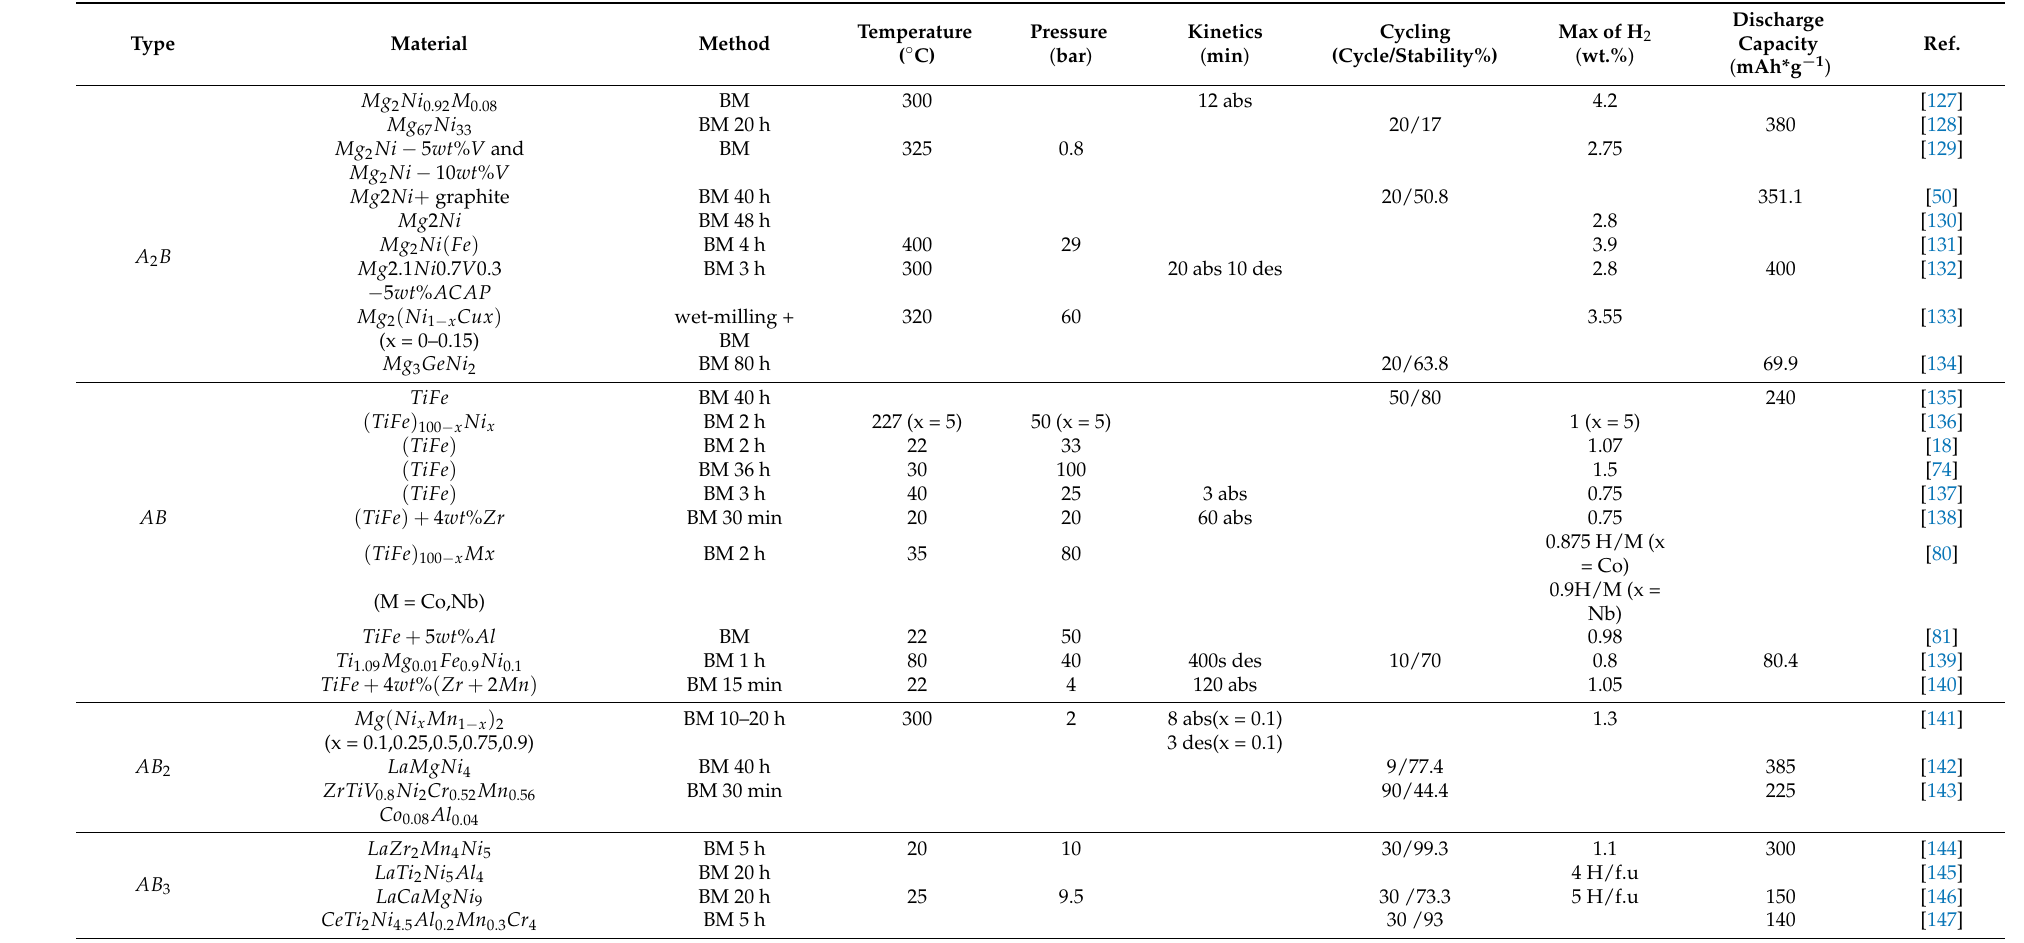
Table 1. H 2 absorption/desorption properties of intermetallic compounds produced by mechanical alloying in the last 5